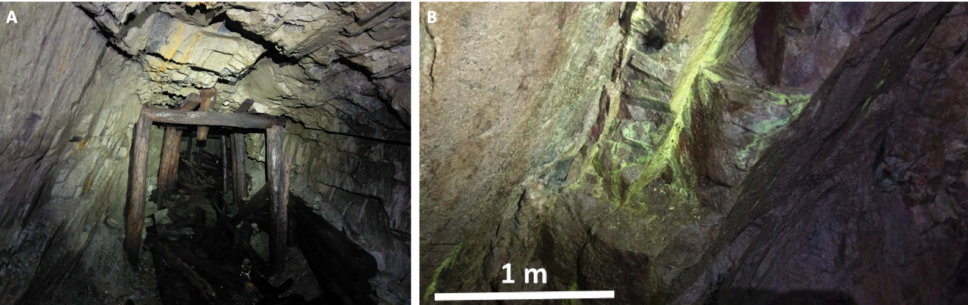
Figure 2. ( A ) Abandoned mine gallery in Podg ó rze mine; ( B ) sampling site with secondary uranyl minerals in adit 19 of the